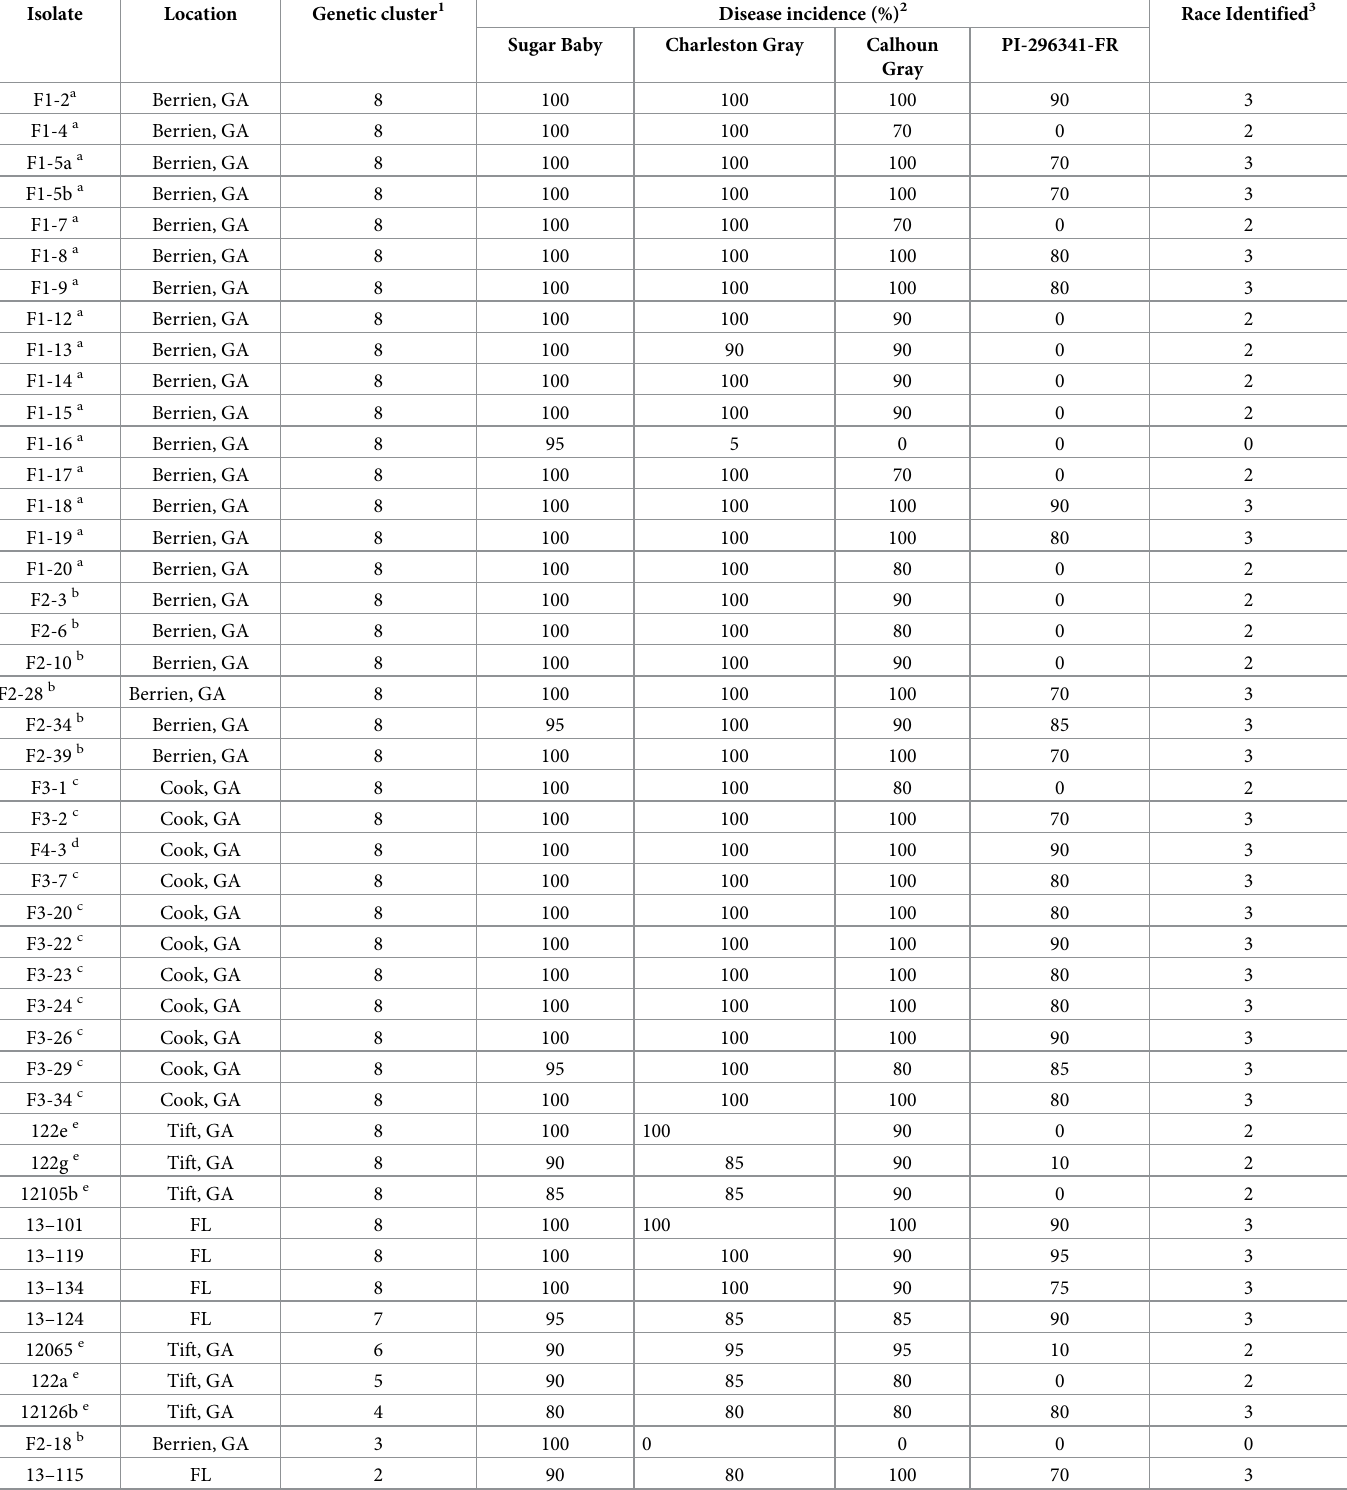
Table 1. Location of isolation, genetic cluster assignment, and races of Fusarium oxysporum f. sp. niveum isolates from watermelon in Georgia and Florida.